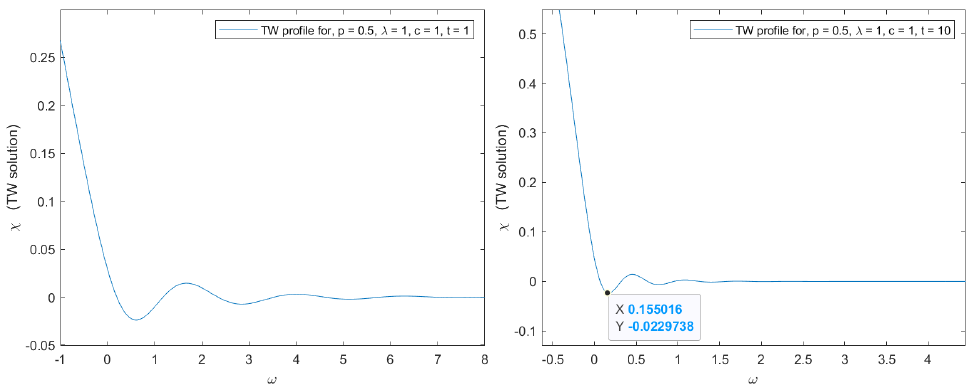
Figure 8. Idem for higher time values.